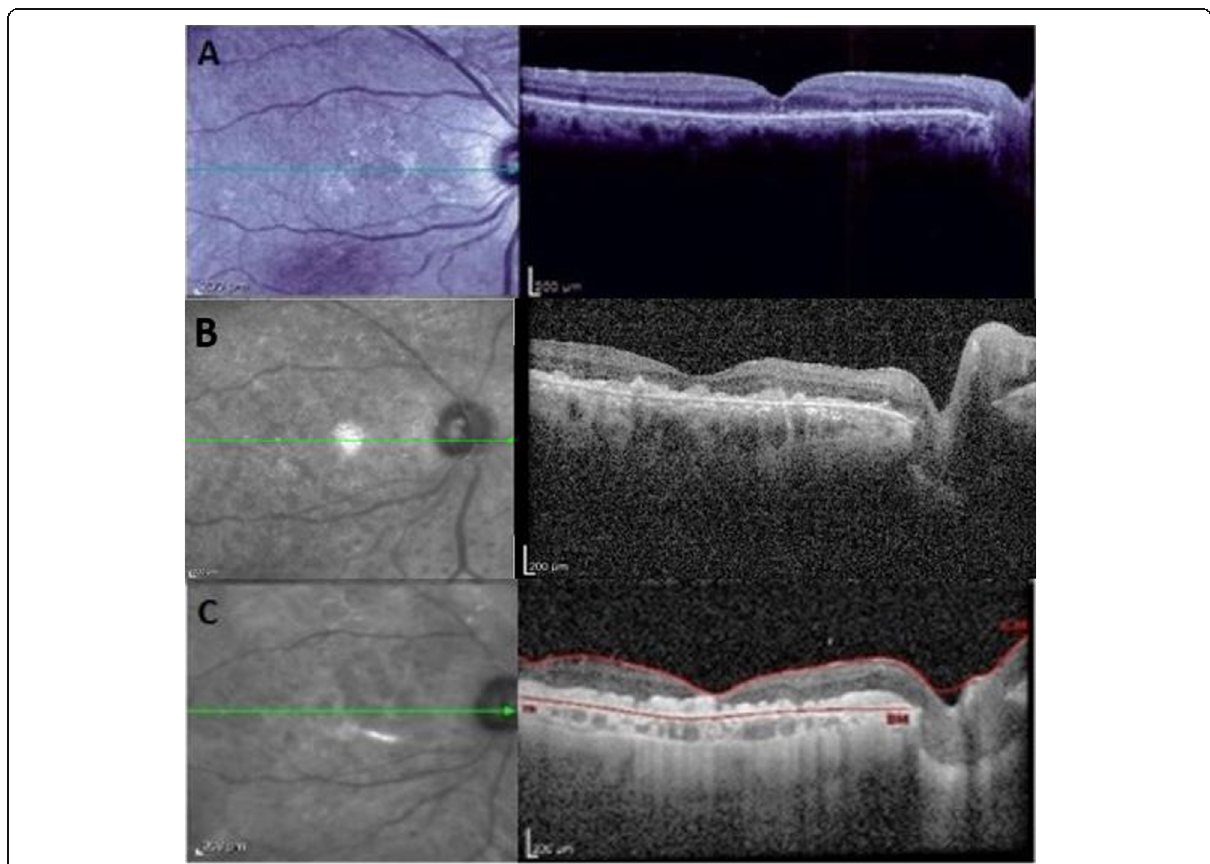
Fig. 1 Optical coherence tomography of right eye, ( A ) revealed attached retina with attenuation of the ellipsoid zone (EZ), two vertical hyper reflective lines (Arrow) are seen between the outer retinal layers of the retina and EZ at the foveola. B Vitreous opacity obscured retinal details although, irregularity of the ellipsoid zone and outer retinal layers and multiple confluent subretinal and sub-RPE hyper reflective nodular lesions are seen, ( C ) the vitreous infiltration was improved, but the sub retinal and sub-RPE infiltrations were